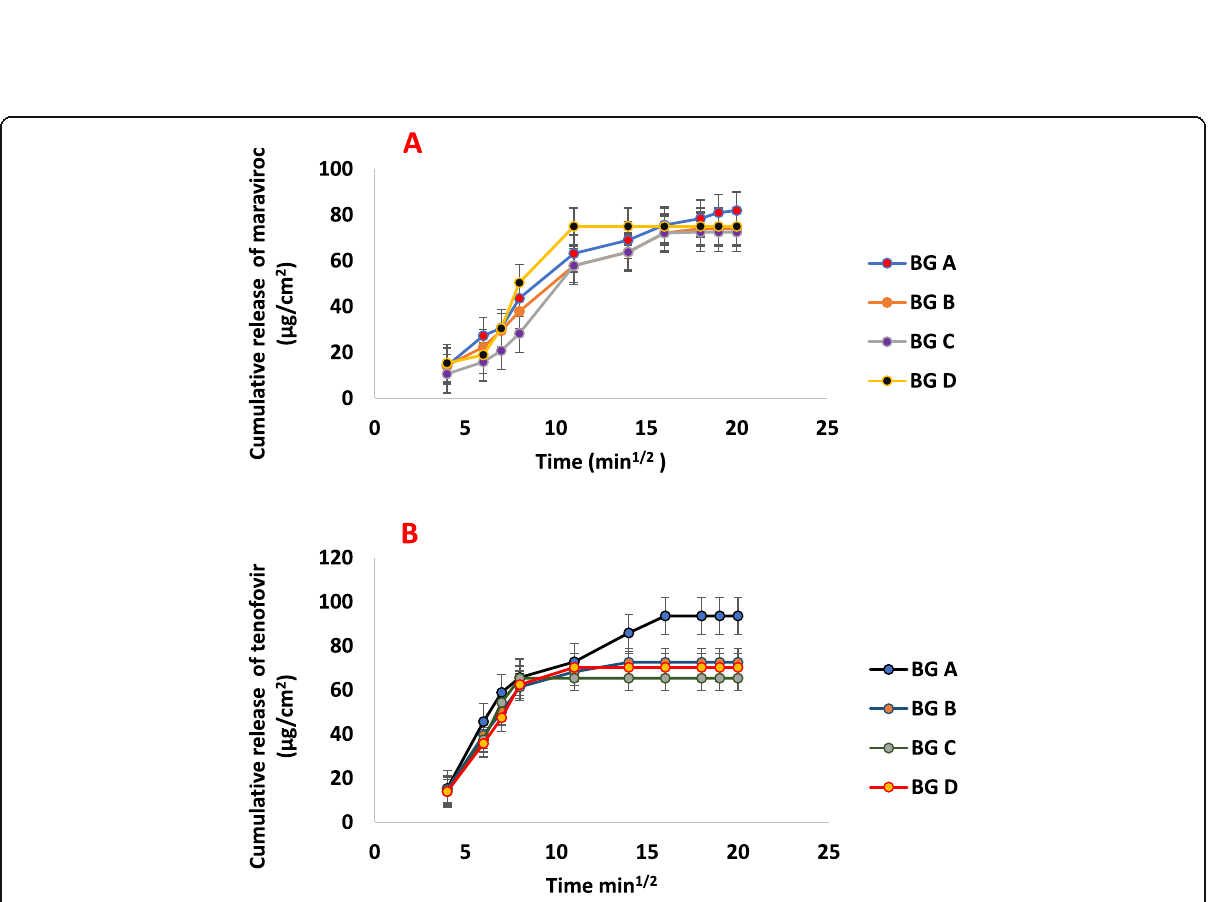
Fig. 2 a DSC scans of maraviroc/tenofovir bigel formulations BG A, BG B, BG C, and BG D. b FTIR spectra of maraviroc/tenofovir bigel formulations BG A, BG B, BG C, and BG D